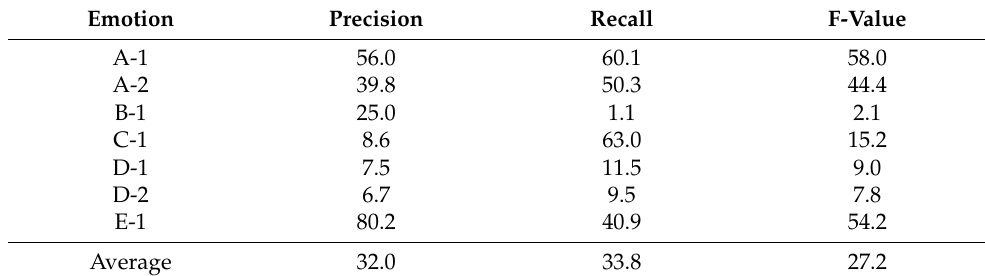
Table 12. Experimental results of emotion estimation (Model-2). Emotion Precision